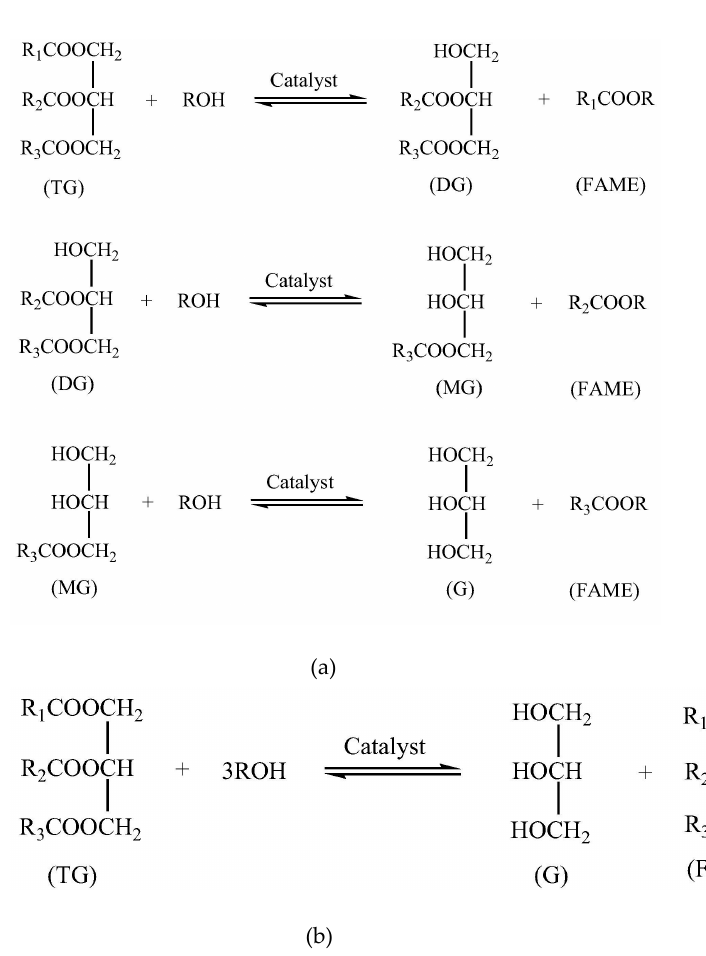
Figure 4. Transesterification reaction process [64]. ( a ) Transesterification of triglycerides; ( b ) Transesterification of triglycerides;( b ) Fast transesterification.